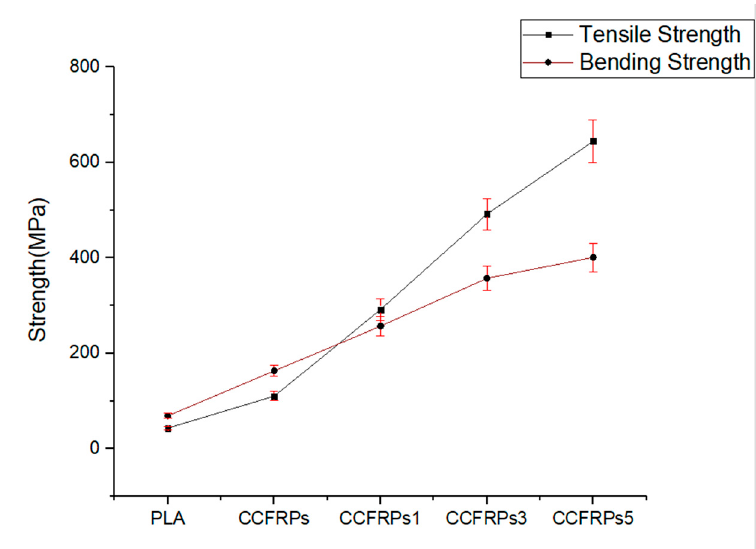
Figure 10. The tensile strength and bending strength of parts under different pressures.